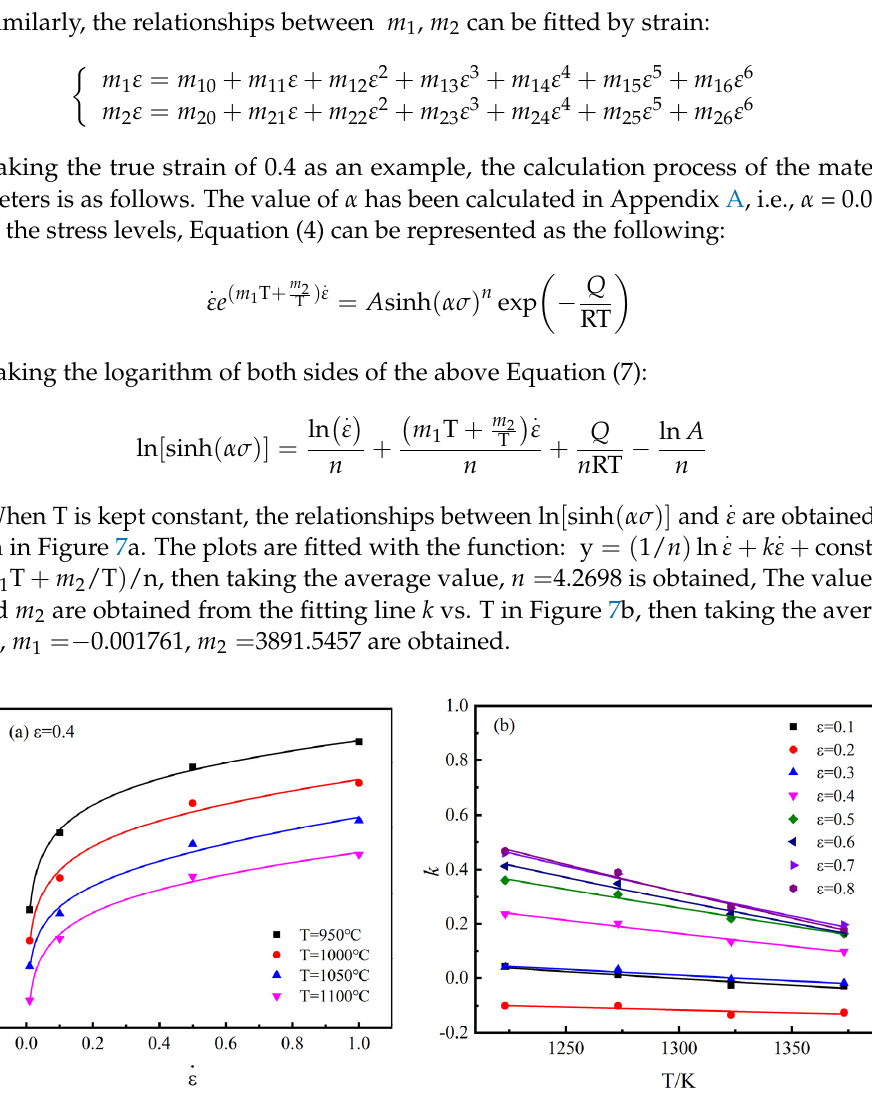
Figure 7. Fitting line ( a ) ln(cid:4670)sinh(𝛼𝜎)(cid:4671) vs. 𝜀(cid:4662) ; ( b ) 𝑘 vs. T . When 𝜀(cid:4662) is kept constant, the relationships between ln(cid:4670)sinh(𝛼𝜎)(cid:4671) and T are obtained, as shown in Figure 8. The plots are fitted with the function: y = 𝑘 (cid:2869) T + 𝑘 (cid:2870) (1/T) + constant , 𝑘 (cid:2869) = 𝑚 (cid:2869) 𝜀(cid:4662)/𝑛 , 𝑘 (cid:2870) = 𝑚 (cid:2870) 𝜀(cid:4662)/𝑛 + 𝑄/R𝑛 , then taking the average value, 𝑄 = 303.7526 KJ/mol is obtained.